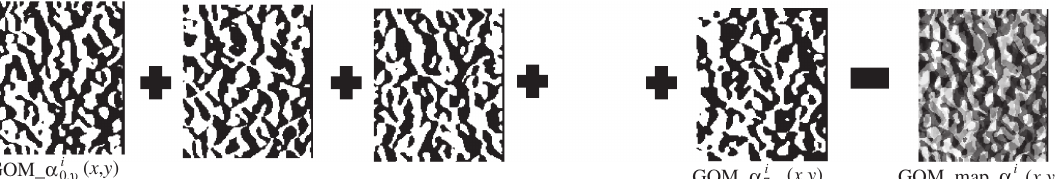
Figure 10: GOM Encoding